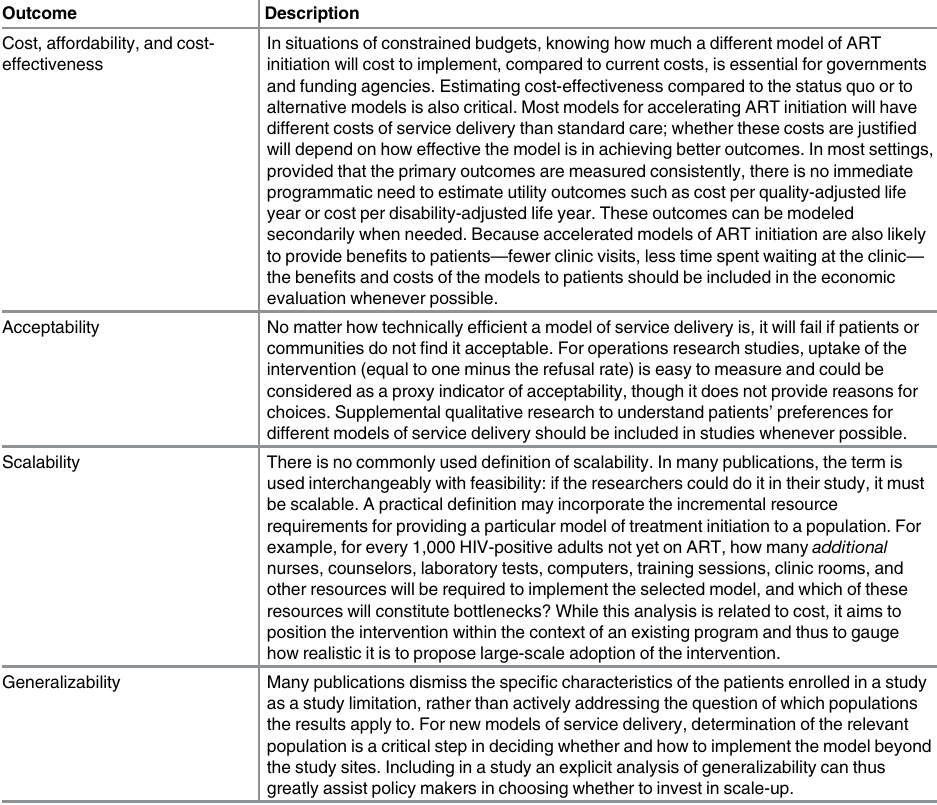
Table 2. Proposed secondary outcomes for evaluation of ART initiation in general adult